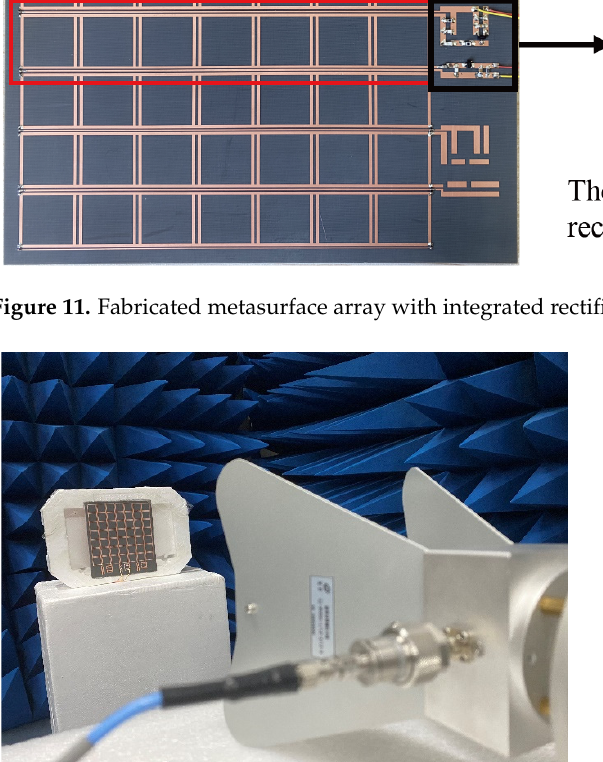
Figure 12. Photograph of metasurface array being measured under broadband horn antenna illumi- nation in the anechoic chamber.